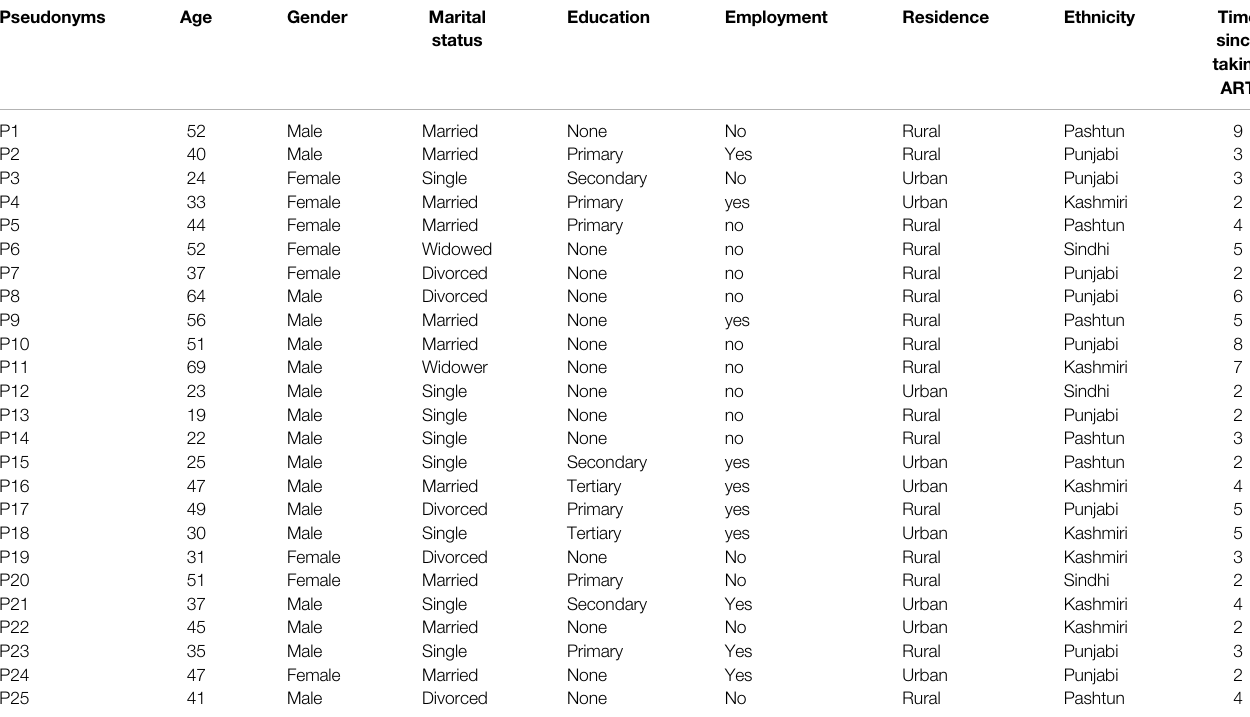
TABLE 1 | Characteristics of study participants.